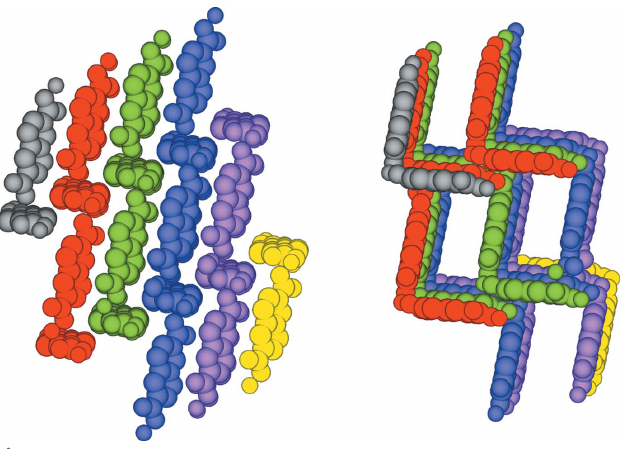
Figure 4 View of the two-dimensional layers in MOF 1 stacked in a self-locking fashion yielding the three-dimensional supramolecular framework.